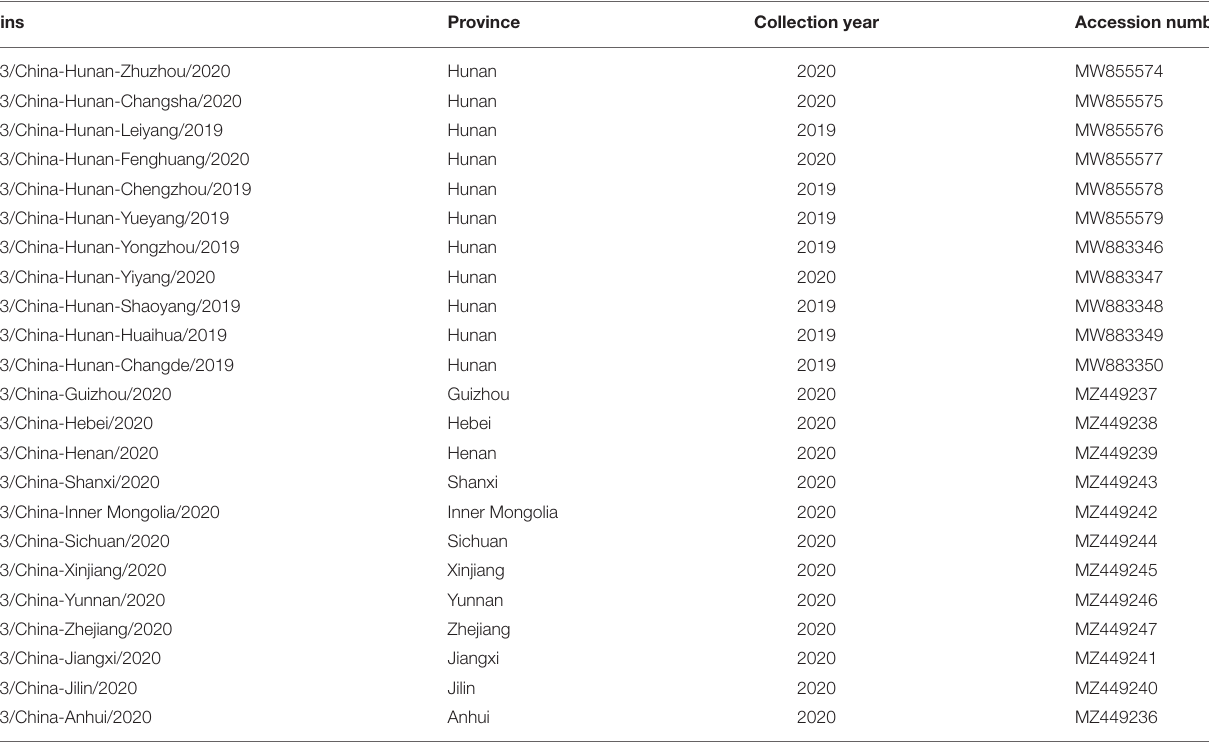
TABLE 4 | Detailed information on the PCV3 strains identified in the present study, including strain name, country, collection date, host, and GenBank accession number. Strains